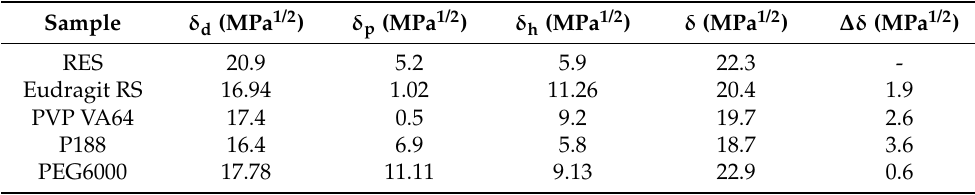
Table 2. The solubility parameter values for drugs and carriers.